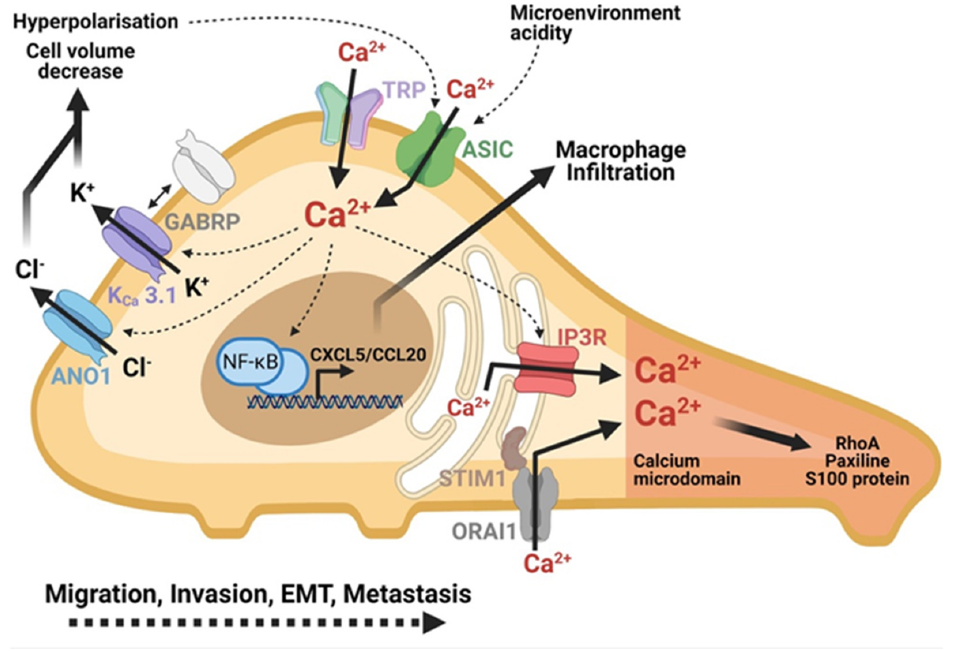
Figure 3 . Role of calcium in PDAC cells mobility and metastasis formation. Calcium plays a central role in migration, invasion and metastasis of PDAC cells. The microenvironment activates the ASIC and TRP channels which contribute to the increase in the intracellular calcium. IP3R channels and SOC-type channels (ORAI1) amplify this increase of intracellular calcium. The formation of a calcium microdomain at the migration front leads to the activation of proteins essential to cell mobility: RhoA, Paxillin, S100 proteins. Calcium entry also indirectly activates the transcription of chemokine-like genes to promote inflammation and invasion. Calcium activates chlorine (ANO1) and potassium (KCa 3.1) channels, which play a role in the regulation of cell volume at the rear pole of the cell in the hyperpolarization of the cell. Created using BioRender.com source, accessed on 8 March A recent study demonstrated that inositol triphosphate receptor (IP3R) channels moved in PANC-1 cells from cell-cell contacts to the leading edges of migrating cells after TGF- β 1 stimulation [13]. The IP3R channels, thus, move towards the lamellipods and the filopodia at the focal adhesion level (Figure 3). This delocalization and accumulation of IP3R channels at the migration front increase the Ca 2 ⁺ sensitivity in this region and pro- mote cell migration. This results in a local increase in Ca 2 ⁺ and paxillin, a protein involved in focal adhesions. Interestingly, they also demonstrated that the change of localization of IP3R channels is accompanied by the accumulation of ER-PR junctions and STIM proteins. Inhibitors of IP3R and STIM channels help to decrease PDAC cell migration. Therefore, a formation of a structural and functional polarity in migrating PDAC cells was observed. The disruption of this polarity could be a way to fight cancer development [13]. It is known that the K + and Cl − channels are also key elements for the regulation of cell volume, a necessary process for cell migration. K Ca 3.1 seems to play an important role in PDAC development [65]. A recent study has demonstrated for the first time the in- volvement of this channel in the migration of PDAC cells [53]. They demonstrated that the K Ca 3.1 channel was overexpressed in PDAC cells, and its inhibition resulted in the loss of cell migration. Moreover, a K + current was activated by Ca 2 ⁺ . Being located at the rear pole of migrating cells (Figure 3), the activation of these channels by Ca 2 ⁺ would allow the efflux of ions and water, contributing to the decrease in cell volume and the retraction of the rear pole of the cell [53]. As concerns the chloride channels, the inhibition of the anoctamin-1 (ANO1) channel (TMEM16A), a Ca 2 ⁺ -activated Cl ⁻ channel, decreases the migration of AsPC-1 and BxPC-